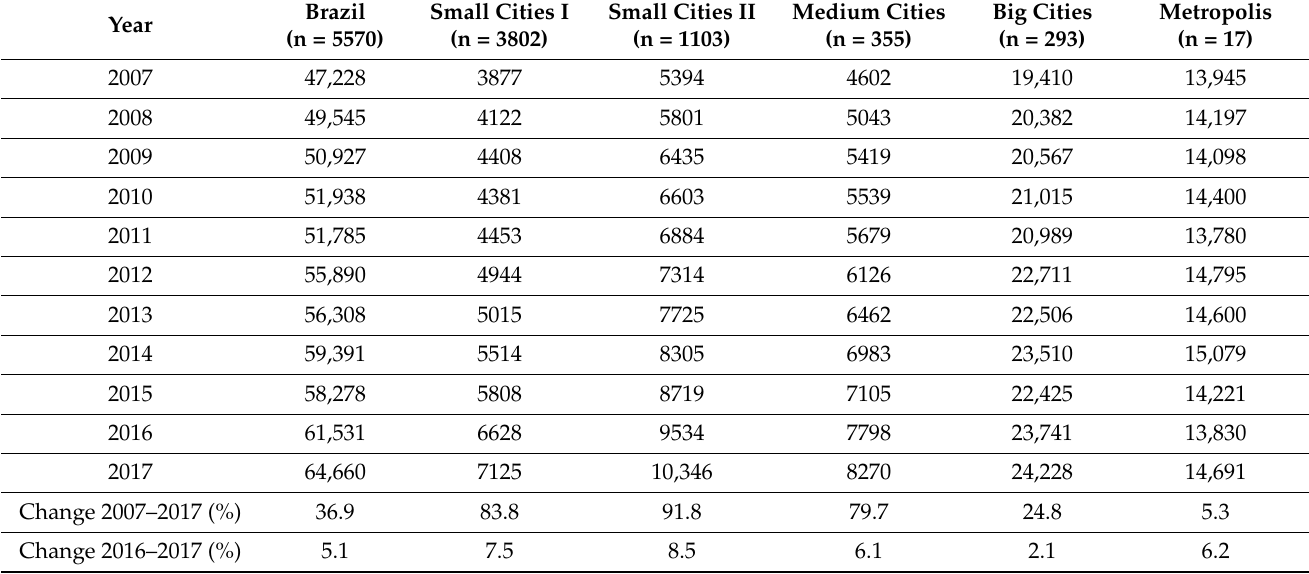
Table 2. Homicide and the change in homicide by city category in Brazil from 2007 to